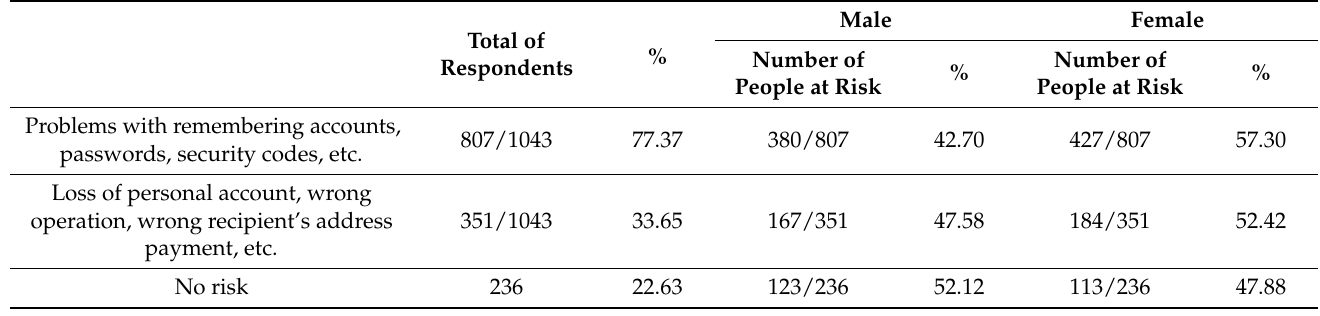
Table 5. Prevalence of risks in using smart devices and online applications.